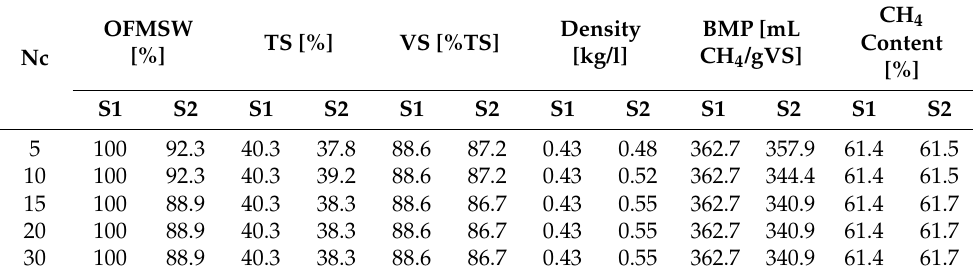
Table 7. Results of the W in streams properties for Scenario 1 (S1) and Scenario 2 (S2).